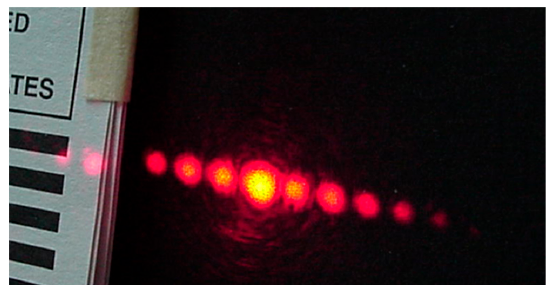
Figure 19. Diffracted orders given by a PVA/PAA grating. Materials 2018 , 11 , x FOR PEER REVIEW